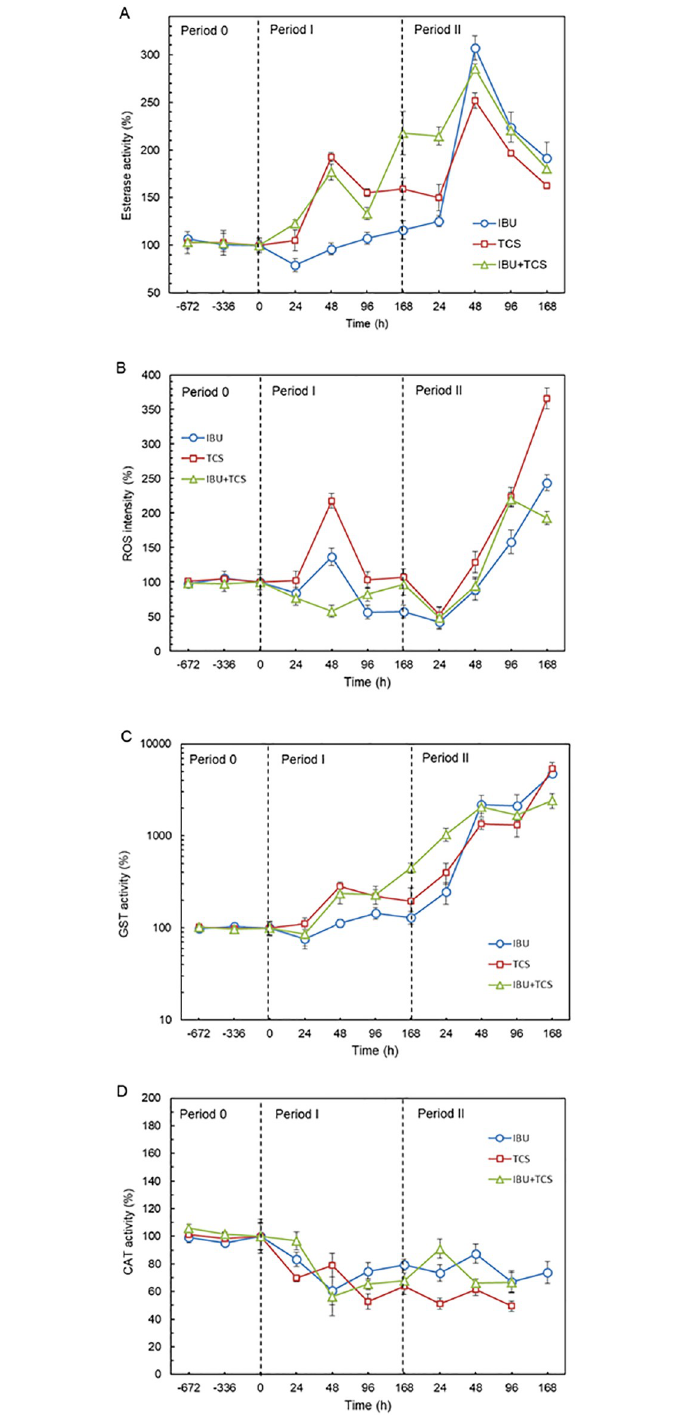
Fig 3. Effect of ibuprofen (IBU), triclosan (TCS) and IBU+TCS mixture on oxidative stress, ROS (A), and esterase (B), glutathione s-transferase, GST (C) and catalase, CAT (D) activities during 14-day assays.